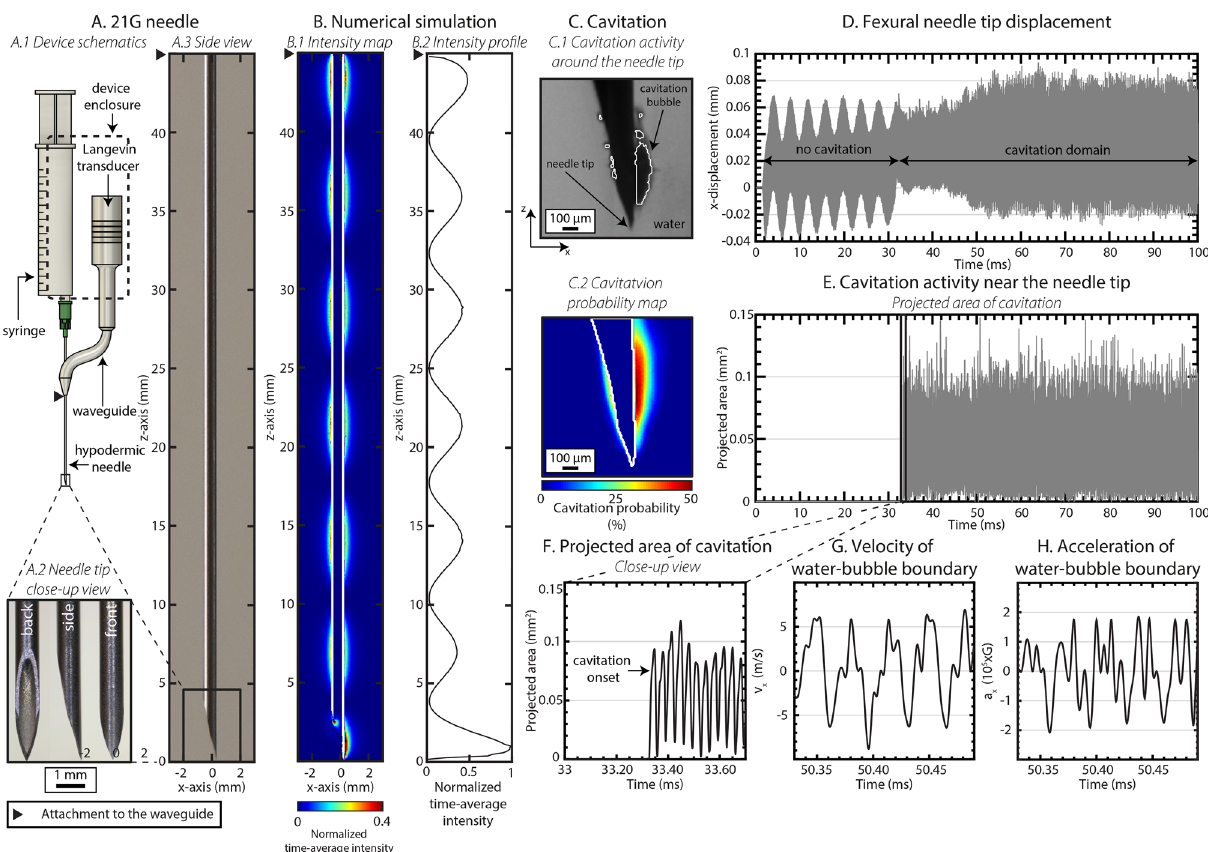
Figure 1. ( A (1)) Schematic represents the investigational device that comprises a conventional Langevin ultrasound transducer coupled via an aluminum waveguide to a ( A (2-3)) 21G hypodermic needle connected to a 10 mL syringe. The geometry permits connecting virtually any pressure source to the needle. ( B (1)) Numerical simulation result representing the x-component of the time-average acoustic intensity evaluated on the xy-plane coincident with the needle center axis and ( B (2)) on a line adjacent to the outer needle surface, starting from the needle tip and ending at the waveguide-needle attachment. These results demonstrate localization of sound energy at the very tip of the needle, more than double the intensity calculated elsewhere. ( C (1)) The cavitation activity is highly concentrated at the needle tip, as supported by ( C (2)) the projected spatial probability of cavitation in deionized water ([ O 2 ] 5.8mg L − 1 ). ( D – F ) Temporally we observed a cavitation onset after